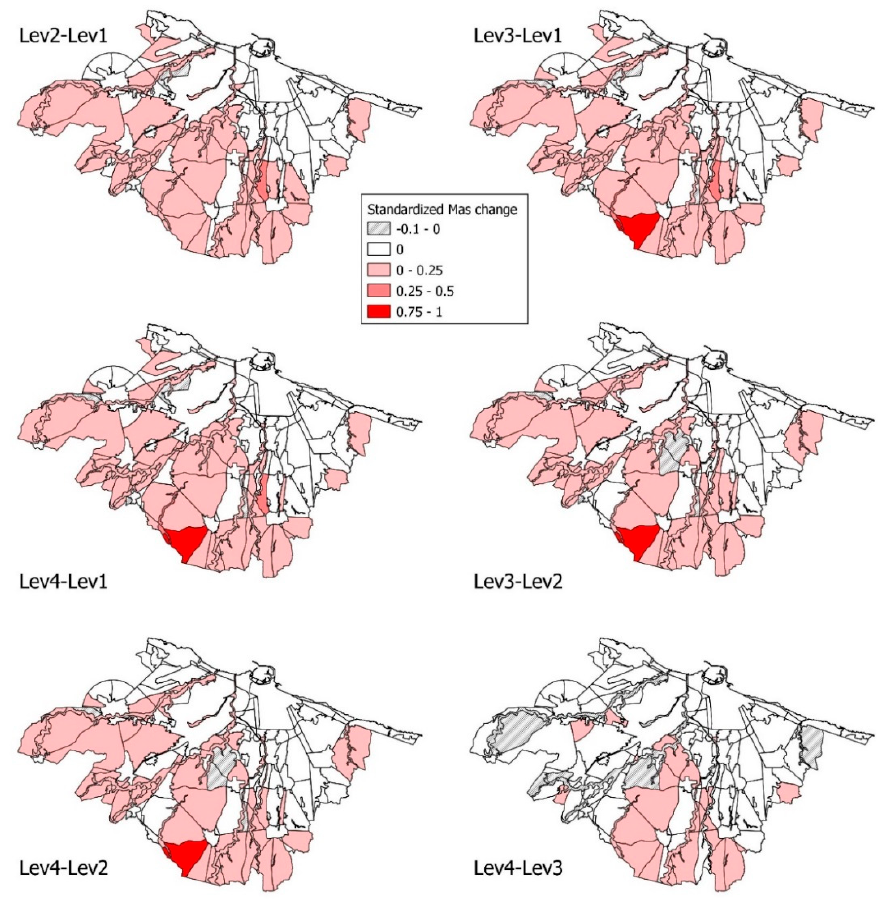
Figure 8. Asymptotic Generalized Biological Energy (M as ) change between couples of CORINE levels–standardized values. Note that M as changes are divided by the maximum M as change among the six level comparison couples.